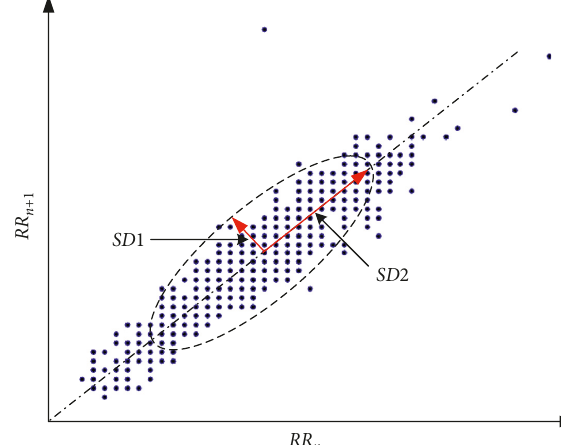
Figure 1: Standard Poincar´e plot. SD1 and SD2 are the minor and major axes of the fitted ellipse,